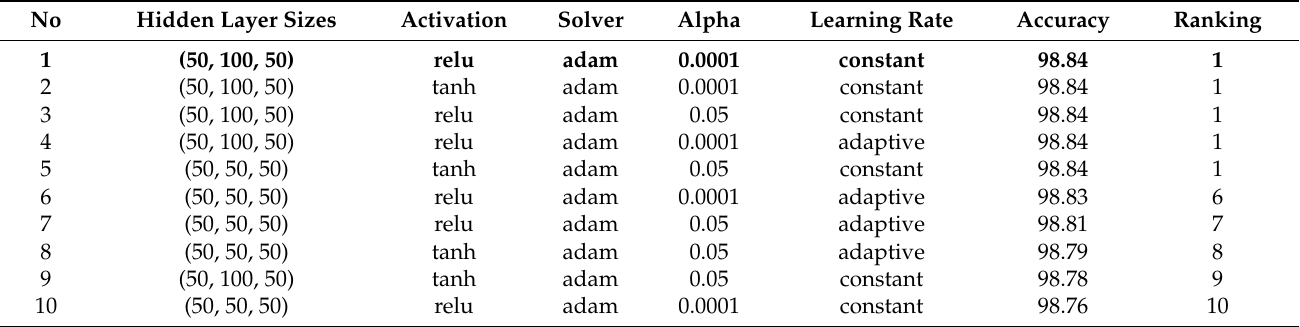
Table 11. Artificial neural network algorithm hyperparameter optimization